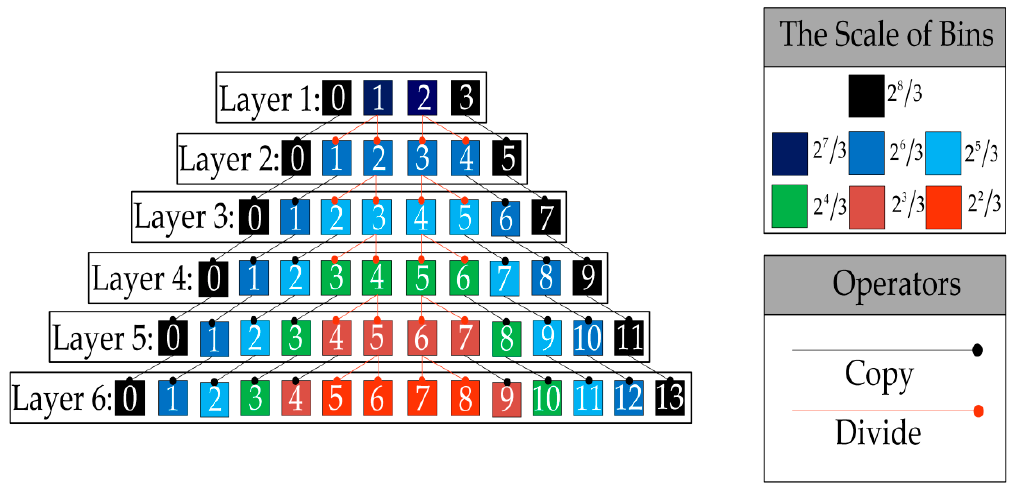
Figure 2. The details of the six-layer color quantizer.